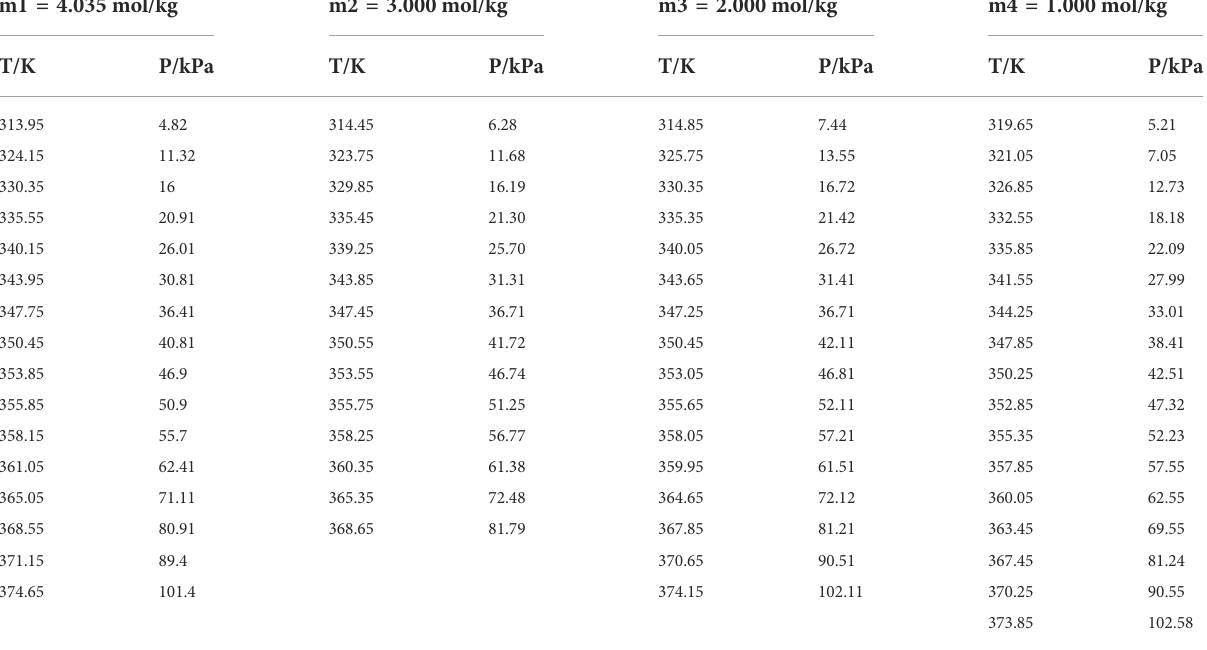
TABLE 3 Experimental VLE data for temperature T , pressure P , and molality m for the L -serine + H 2 O system a .